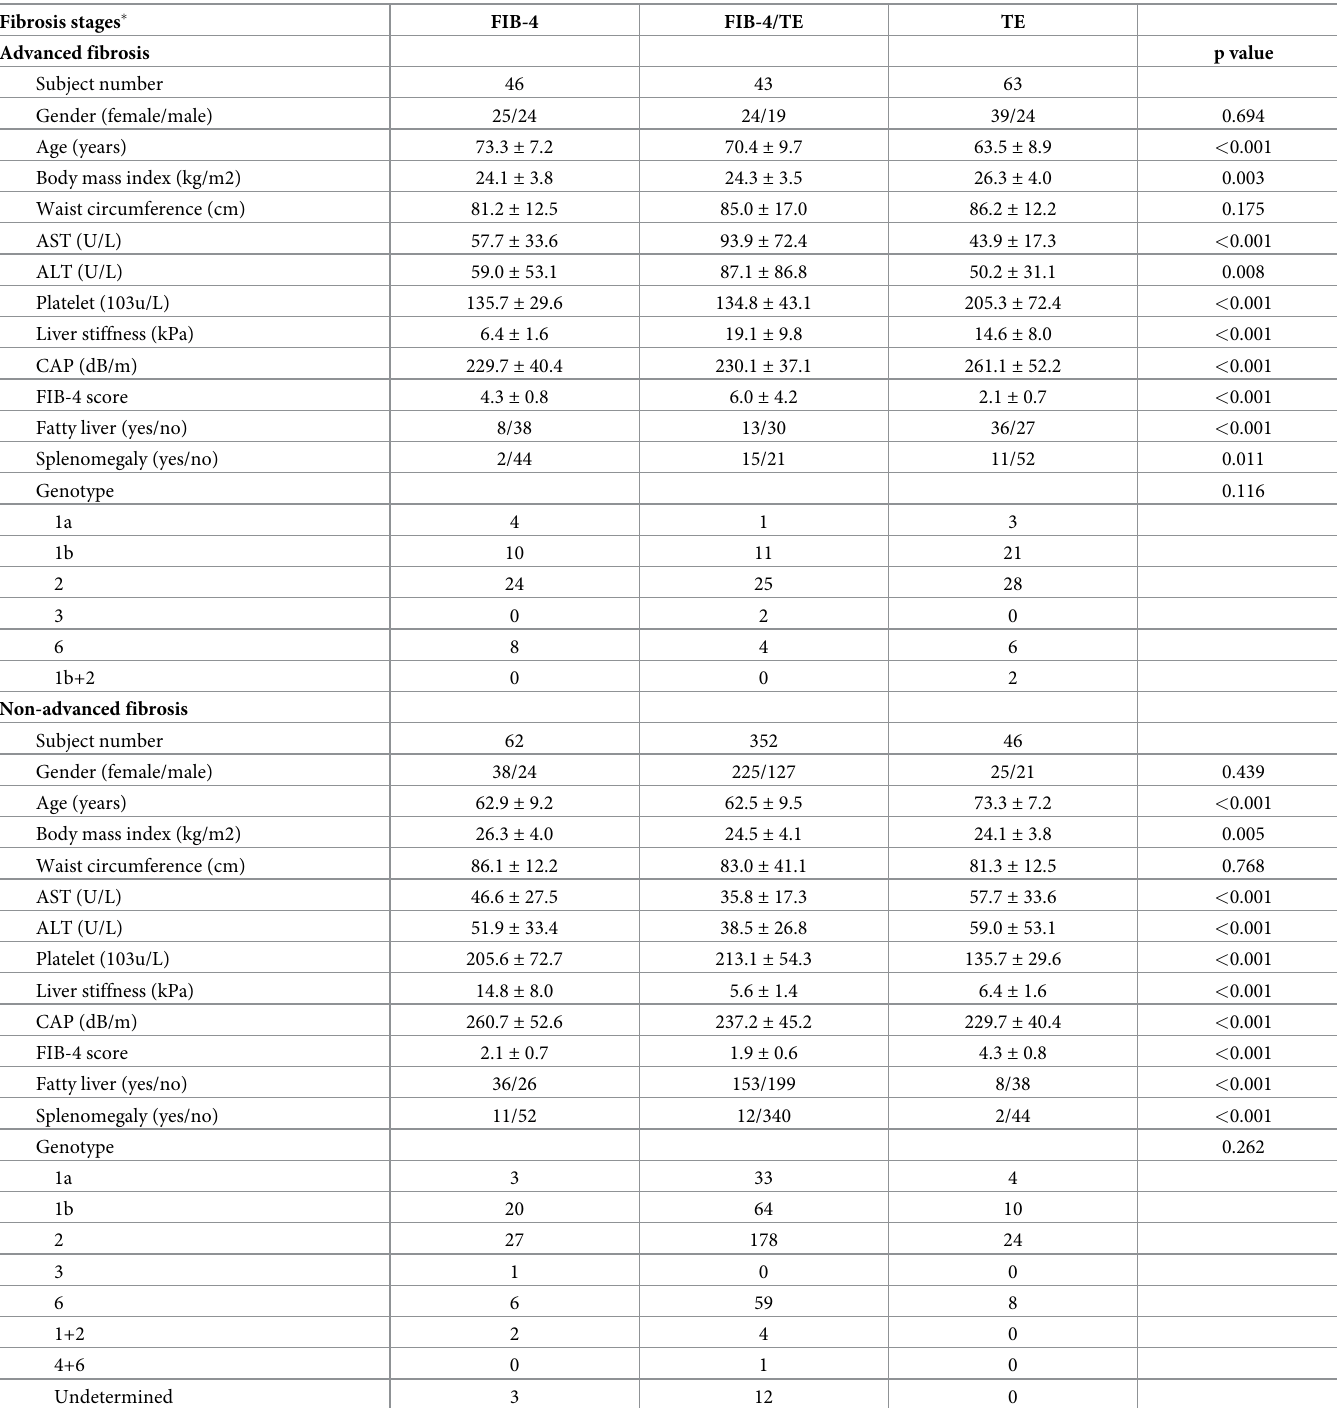
Table 3. Comparisons of characteristics of fibrosis stages by FIB-4 or transient